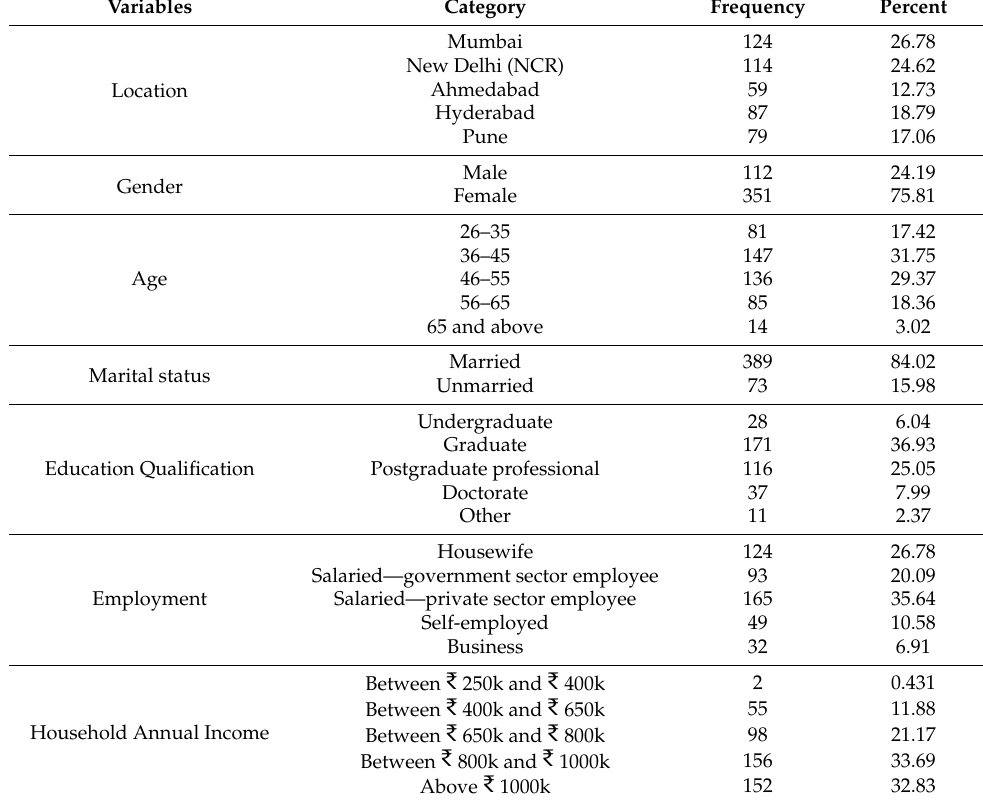
Table 1. Descriptive